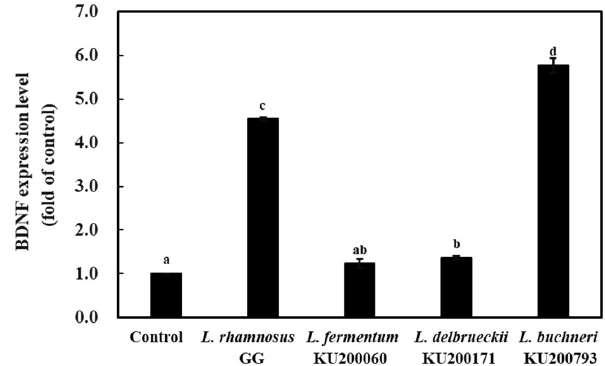
Figure 2. mRNA expression levels of the brain-derived neurotropic factor (BDNF) gene in heat-killed lactic acid bacteria (LAB) treated HT-29 cells using RT-PCR. The fold change was calculated based on normalization with GAPDH gene expression. Control group was treated with PBS. L. rhamnosus